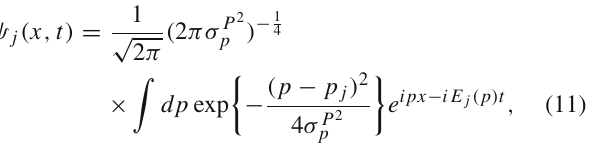
Fig. 4 NAQCinequalityasafunctionofthedistanceforthreedifferent wave packet widths σ x : σ x = 5 × 10 − 6 (green line), σ x = 2 . 5 × 10 − 6 m (blue line) and σ x = 1 . 7 × 10 − 6 m (orange line). The value of the energy is E = 2MeV.Thedot-dashedhorizontallineistheboundoftheNAQC